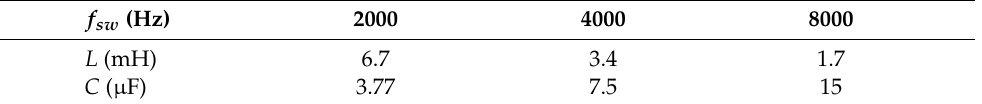
Table 4. Inductor and capacitor values for a cut-off frequency of f 0 = 1000 Hz, depending on switching frequency ( f sw ).